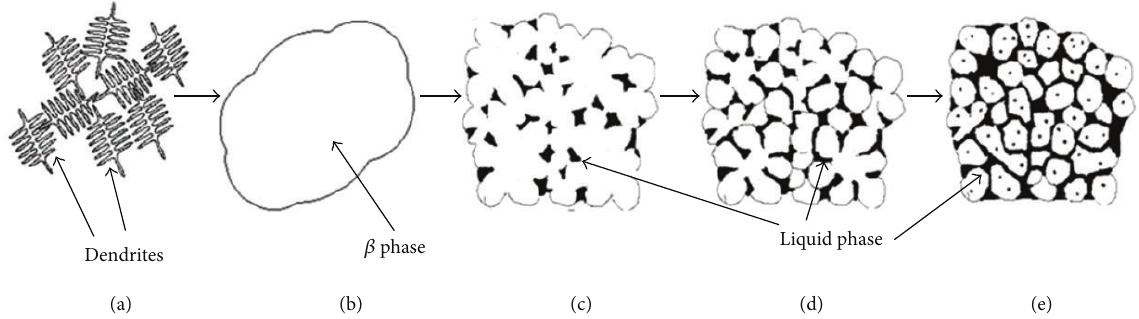
Figure 34: Schematic illustration of microstructural evolution from the as-cast sample: (a) the initial dendritic structure; (b) homogeneous 𝛽 phase after solution treatment at 330 ∘ C for at least 3 h; (c)–(e) microstructures when (b) was partially remelted at 438 ∘ C for 15, 30, and 60 min, respectively [69].